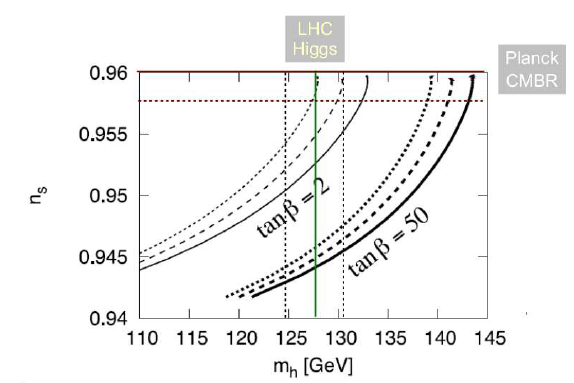
Figure 3: Planck best-fit value of the spectral index and m h = 126 GeV/c 2 from LHC fits very well MSSM inflaton model with small β (adapted from Ref. [29]).